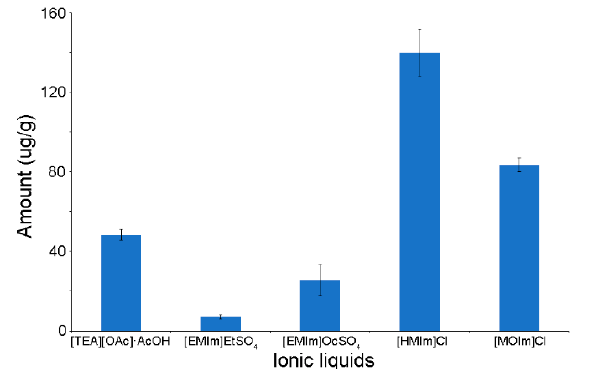
Figure 4. Effect of IL type on 20-E extraction efficiency from spinach. Figure 4. E ff ect of IL type on 20-E extraction e ffi ciency from